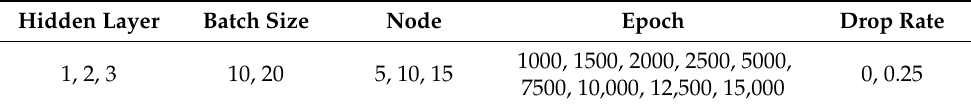
Table 5. Training conditions for the deep neural network.